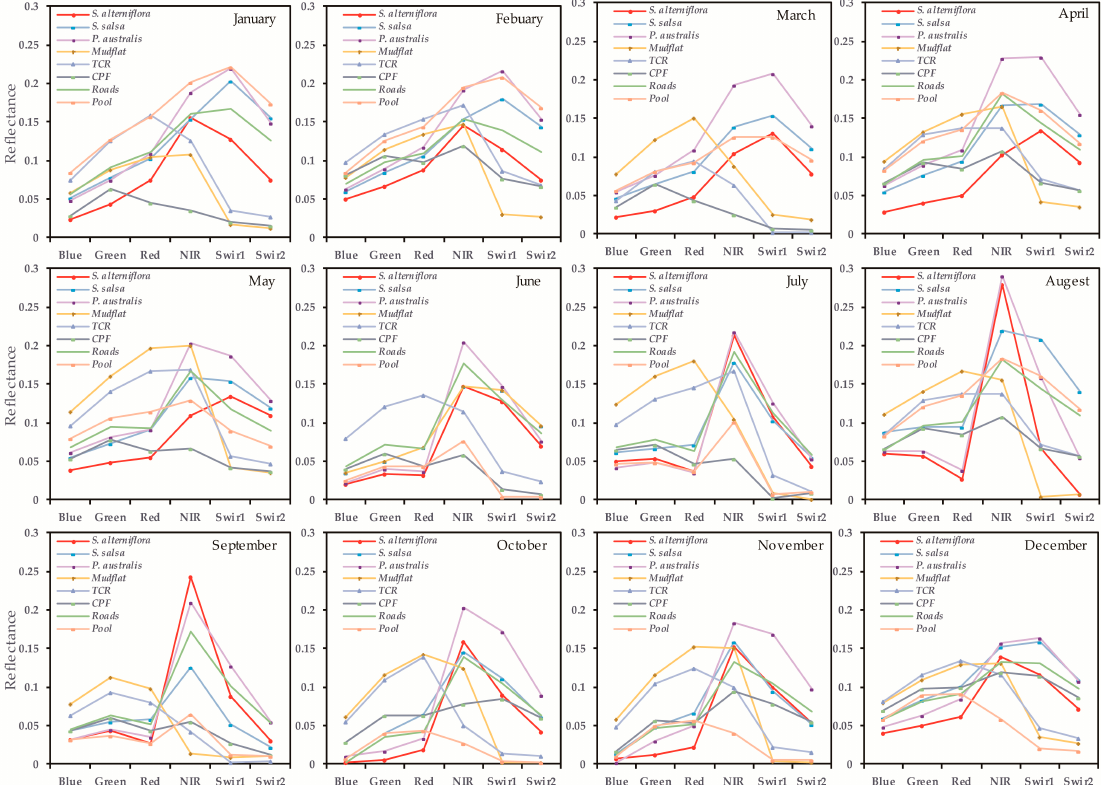
Figure 6. Spectral reflectance curves of S. alterniflora and other land covers for each month in 2014. TCR: Tidal Channel and River. CPF: Culture Pond and Farmland.